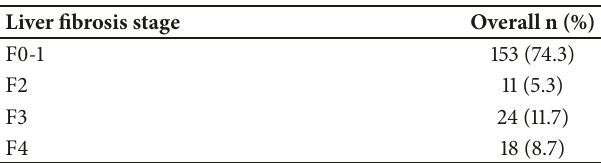
Table 2: Prevalence of liver fibrosis by vibration-controlled tran- sient elastography in chronic hepatitis B